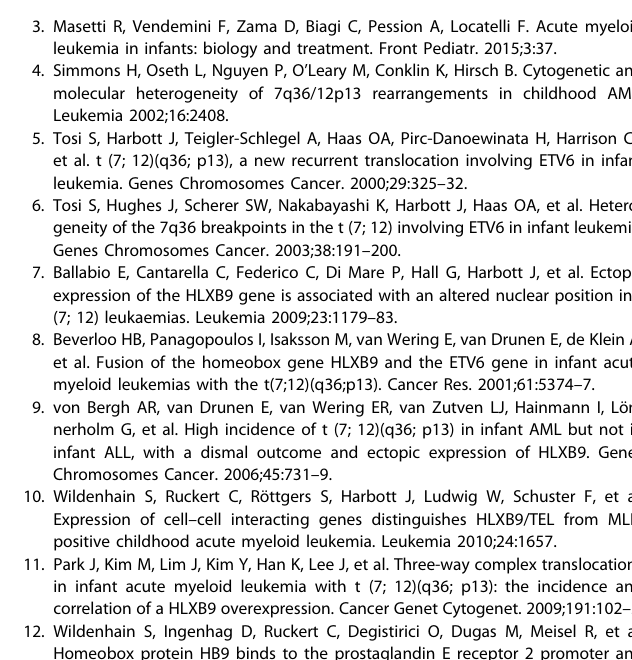
Fig. 4 Comparison of K562-t(7;12) transcriptional landscape with t(7;12) patient signatures. A 177-gene signature of t(7;12)-patient gene expression extrapolated from published microarray and RNA sequencing datasets by comparison with other paediatric AML subtypes. The Venn diagram shows the 177 intersect genes. B 121-gene t(7;12)-speci fi c signature inferred by comparisons of gene expressions of paediatric AML and normal bone marrow (NBM) samples. Edward ’ s Venn diagram highlight the 121 exclusive genes to t(7;12). C , D Gene Ontology analysis of the 177-signature and 121-signature by the PANTHER annotation repository of biological processes (BP). E , F GSEA enrichment plots of K562-t(7;12) gene expression pro fi le using the 177- and 121-signatures. NES normalised enrichment score, FDR false discovery rate. G Core enriched genes from the GSEA using the 177- and 121-signatures, shown by their enrichment index in K562-t(7;12) against K562-Ctrl. MNX1 is highlighted by the